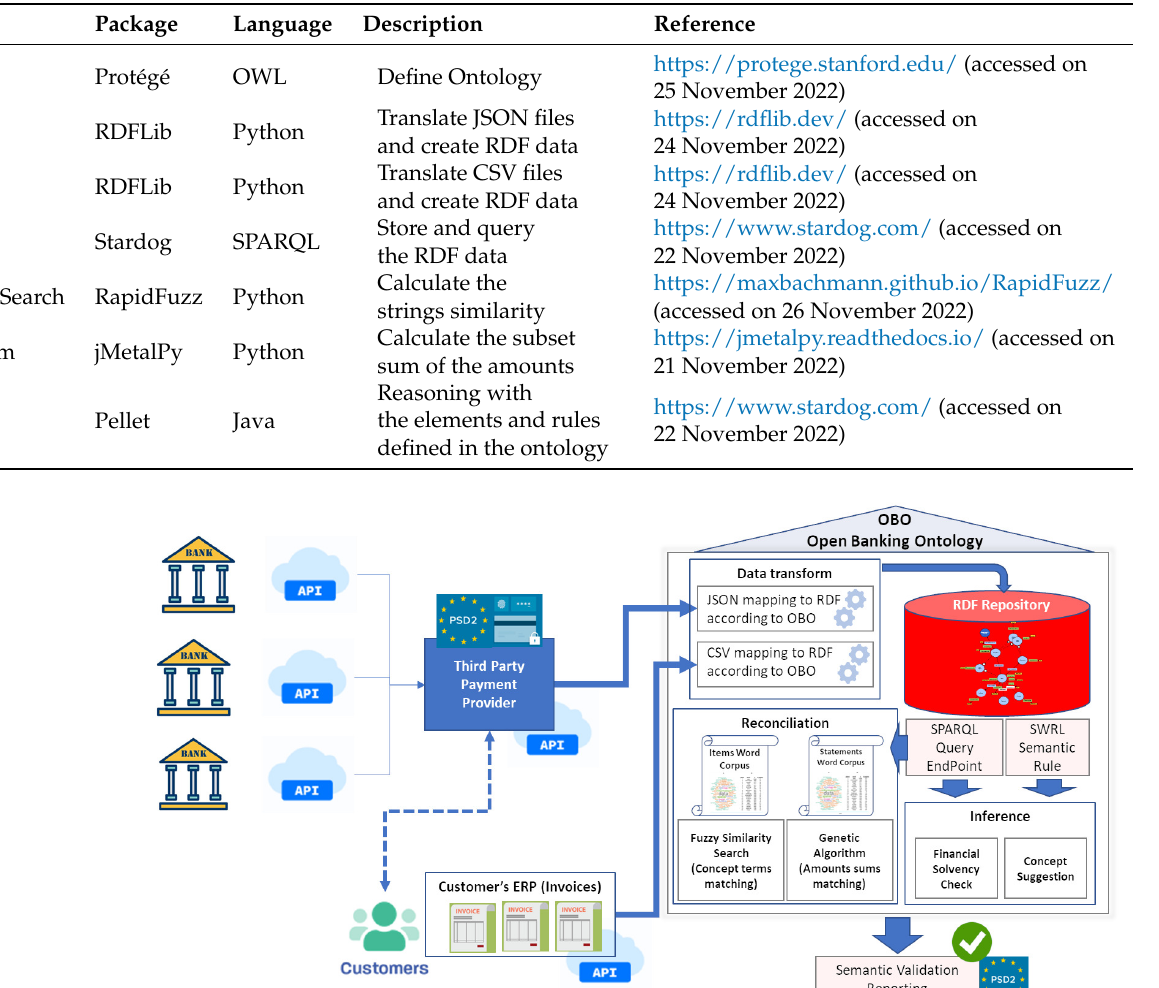
Table 7. Methods and packages used at each step.